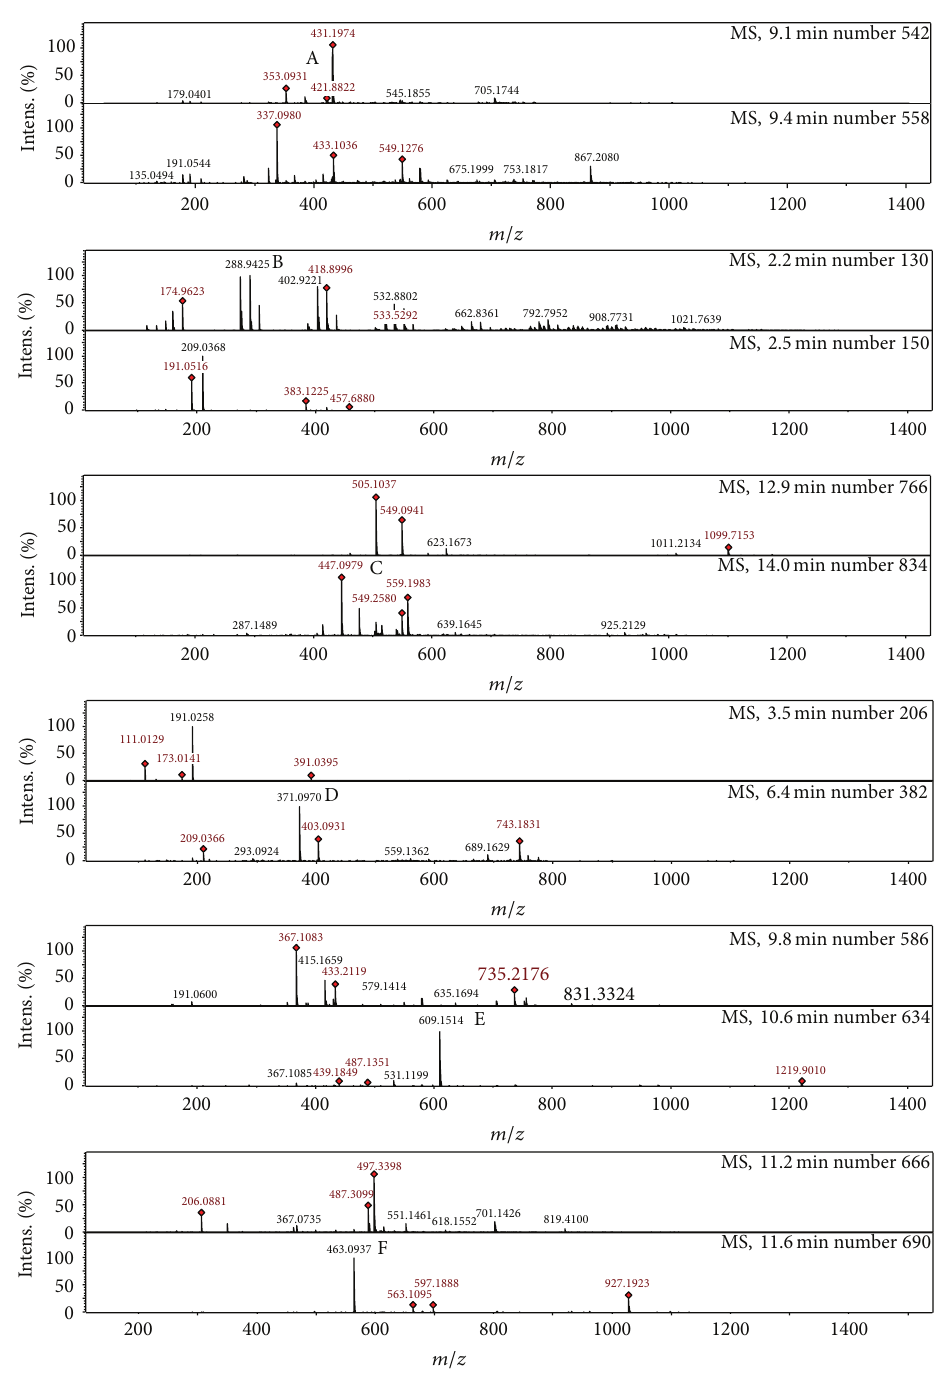
Figure 1: LCMS chromatogram of phenolic acid and flavonoids in the aqueous extract of Nauclea latifolia leaves. (A) Chlorogenic acid, (B) catechin, (C) cynaroside, (D) tangeritin, (E) rutin/hesperidin, and (F) hyperoside.